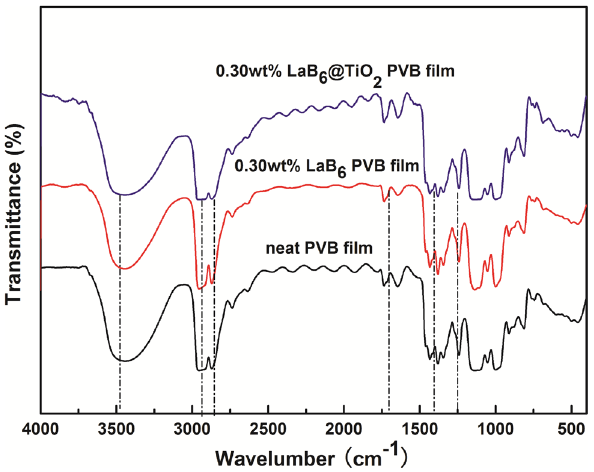
Figure 4: FT - IR spectra of the